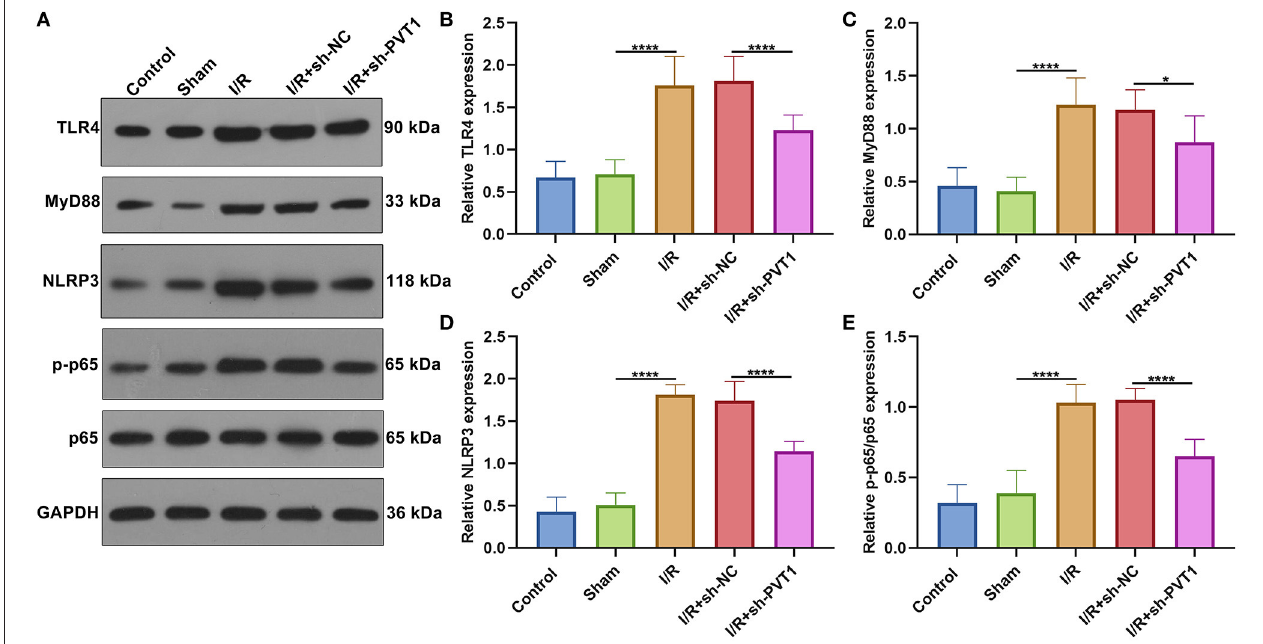
FIGURE 4 | Suppression of pyroptosis by lncRNA PVT1 knockdown involves TLR4/MyD88/NF- κ B/NLRP3 inflammasome pathway in myocardial I/R tissues. (A–E) Western blot of (B) TLR4, (C) MyD88, (D) NLRP3, and (E) p-p65/p65 expressions in myocardial tissues of control, sham, I/R, I/R + sh-NC, and I/R + sh-PVT1 groups. Mice in the I/R + sh-NC and I/R + sh-PVT1 groups were injected by 10 µ L sh-NC or sh-PVT1 via Lipofectamine 2000 reagent. After 48h, myocardial I/R model was constructed. No treatment was done for mice in the control group. The chest of mice in the sham operation group was only opened, but was threaded the corresponding part without ligating the LAD. There were 10 mice in each group. * p < 0.05; **** p <